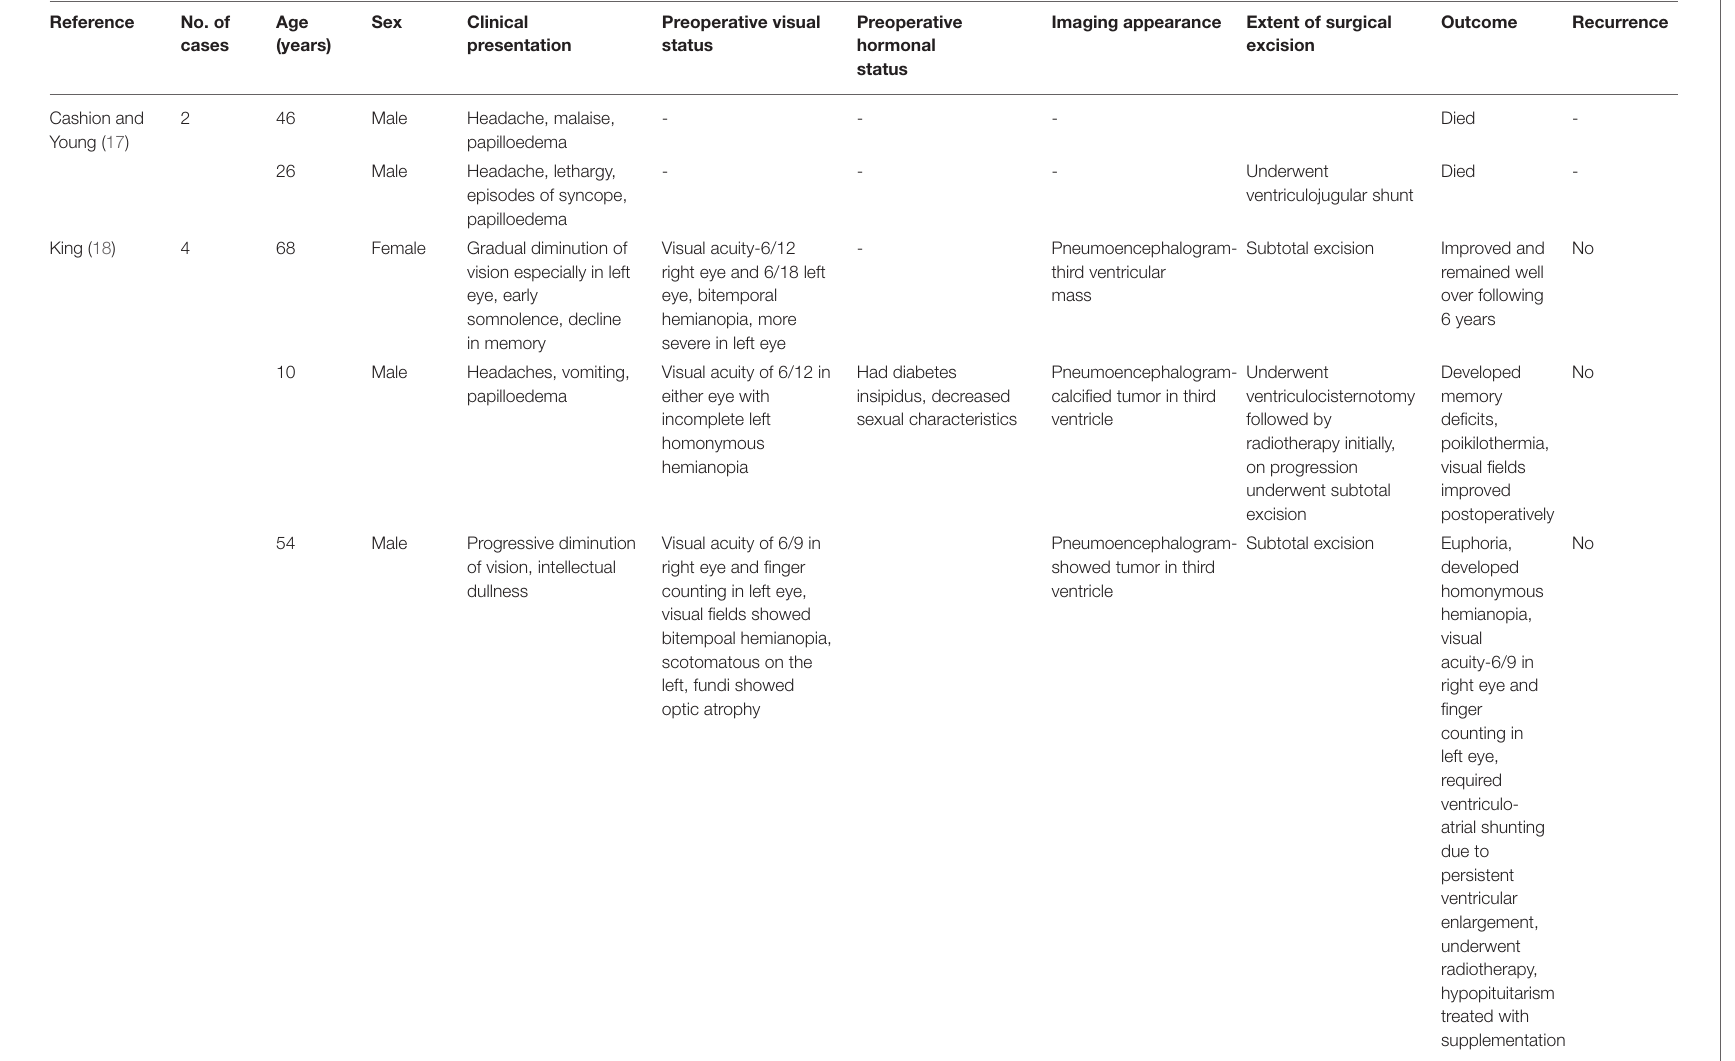
TABLE 1 | Prior reports and series of purely intraventricular craniopharyngiomas in